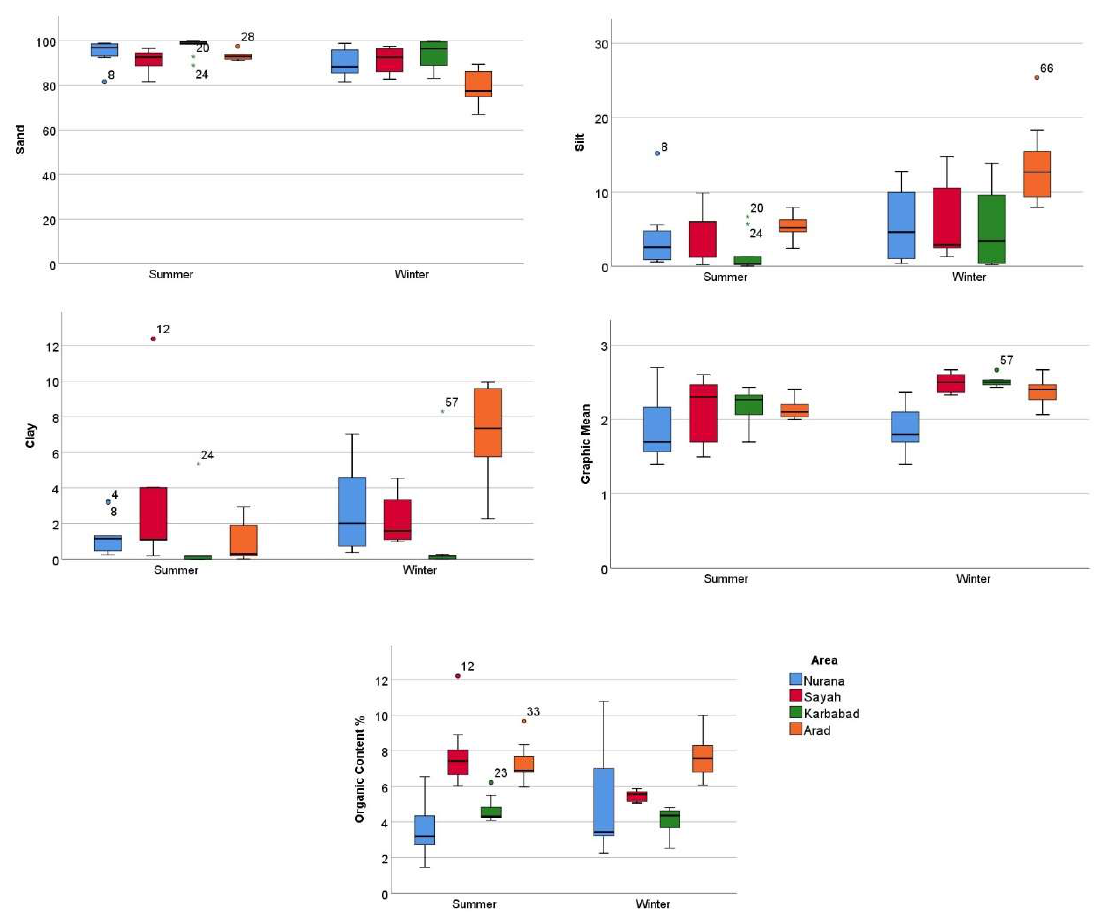
Figure 3. Percentages of sediment particles (sand, silt and clay) and organic content in the sampling areas in the summer and winter seasons, presented as the median and interquartile